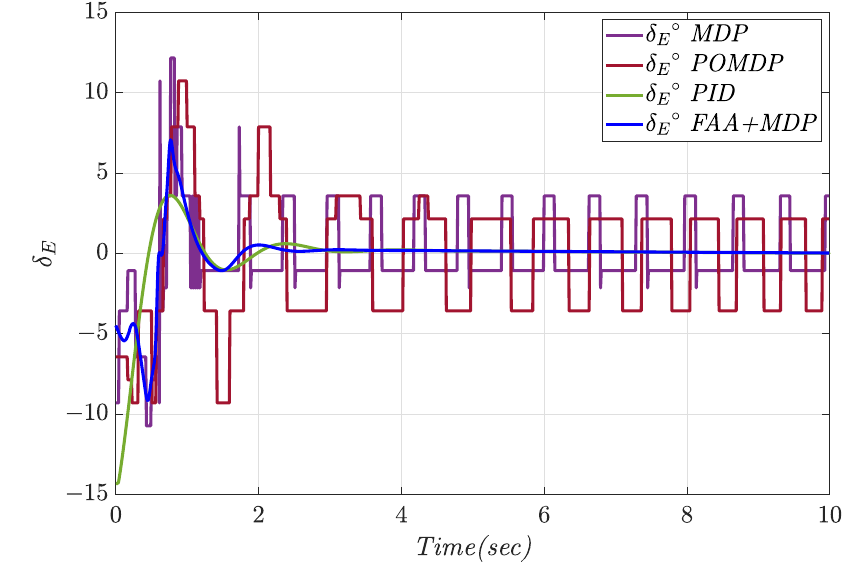
Figure 6. Elevator deflections for θ des = 1 ◦